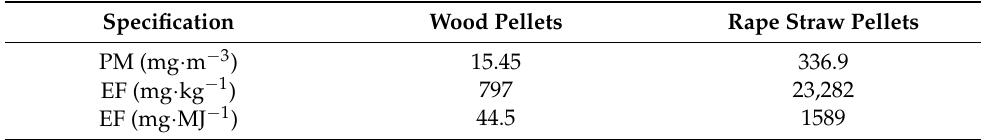
Table 4. Emission factors determined for the tested